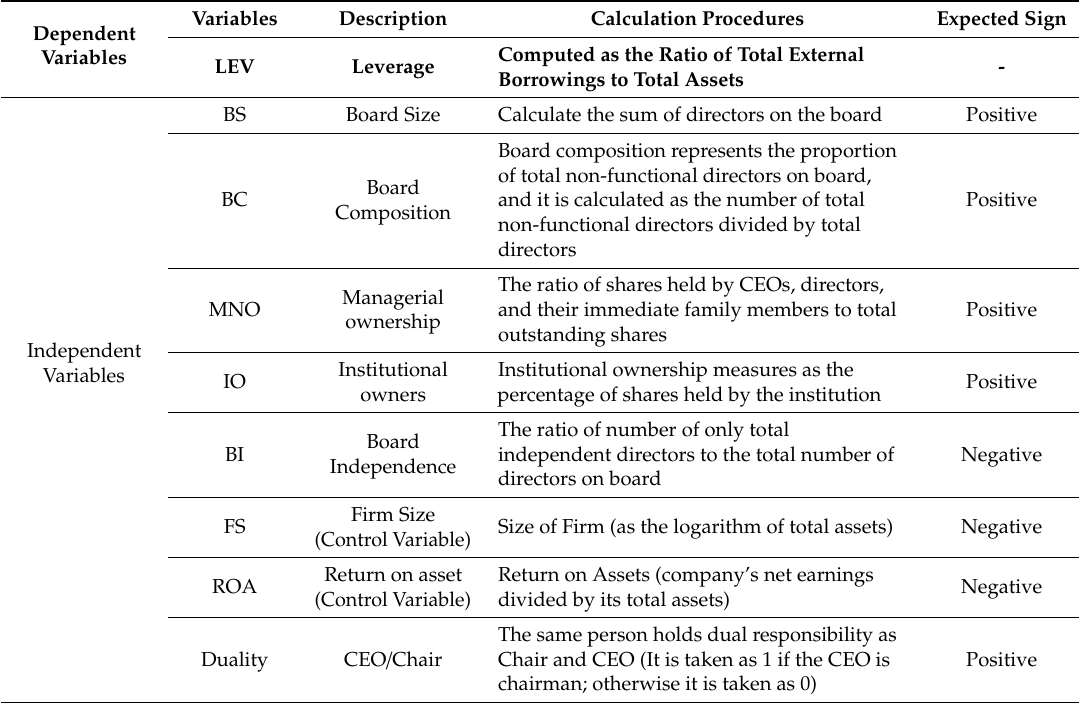
Table 1. Name of the variables and their